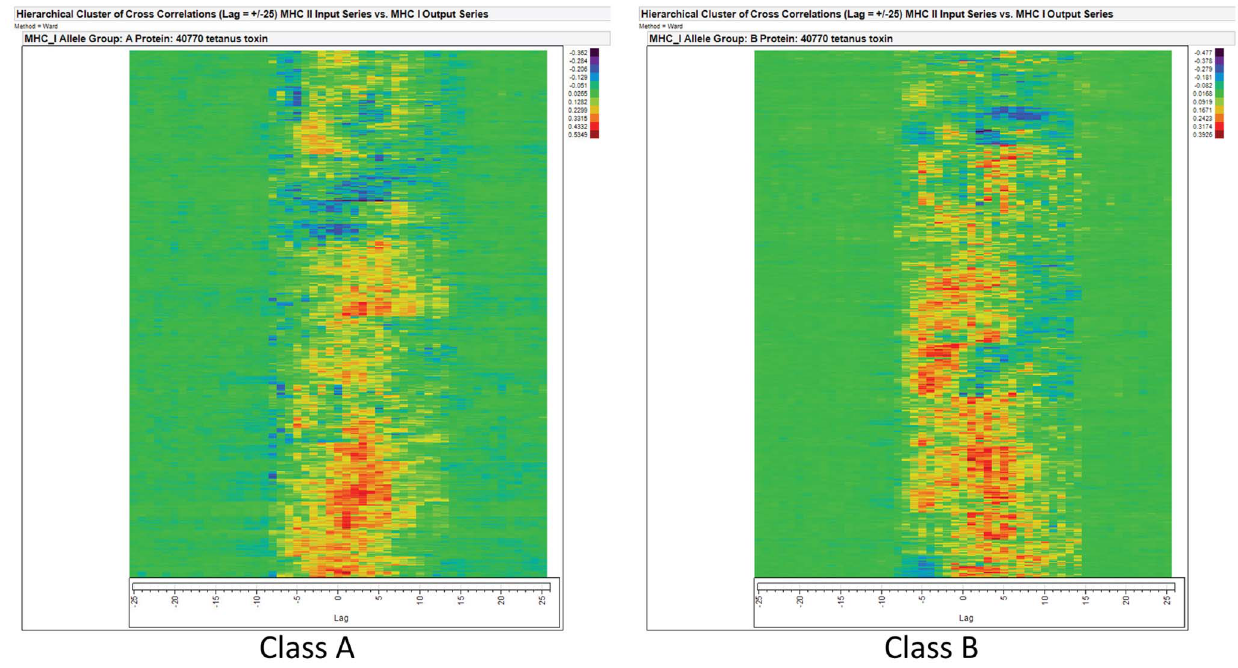
Figure 6. Cross correlation of the position of MHC-I and MHC-II in tetanus toxin. An ‘‘all against all’’ cross correlation was conducted for 28 MHC-II HLA against 20 HLA MHC Class I A (Panel A). This was repeated for 17 alleles of Class I B (Panel B). The vertical line indicates the zero lag position (complete correlation of index position). As both the MHC-I and MHC-II affinities are standardized to zero mean and unit variance, a positive number (red) indicates a strong association between the alleles at that position. A negative number (blue) indicates an anticorrelation between the binding affinities of peptides with an N-terminus at that position. The magnitude and sign of the correlation coefficient for each allele can be determined from the thermometer scale beside the heat diagrams. The corresponding paired plots for all 11 proteins is shown in Figure S3.5.